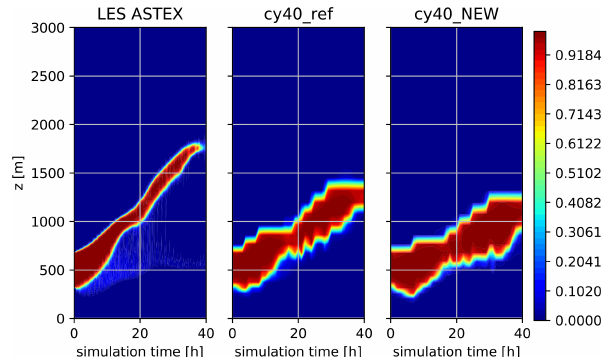
Figure 16. Cloud cover ASTEX case of LES (left panel), cy40REF (middle panel), and cy40NEW (right